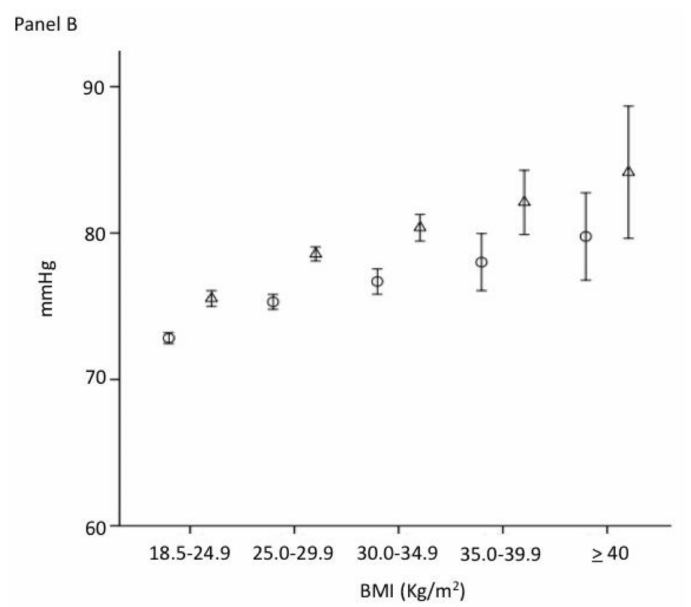
Figure 1. Systolic (panel A ) and diastolic (panel B ) blood pressure (mean and SD) according to the BMI levels ( : women; (cid:52) : men) ( p for trend < 0.001). (cid:35)